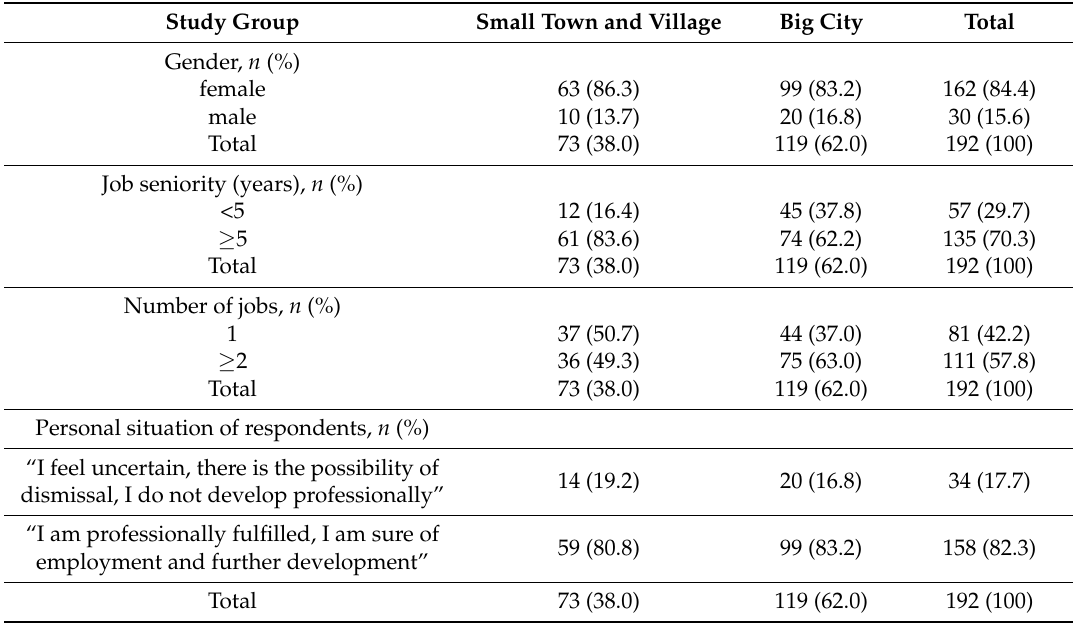
Table 1. Characteristics of the study group, N =